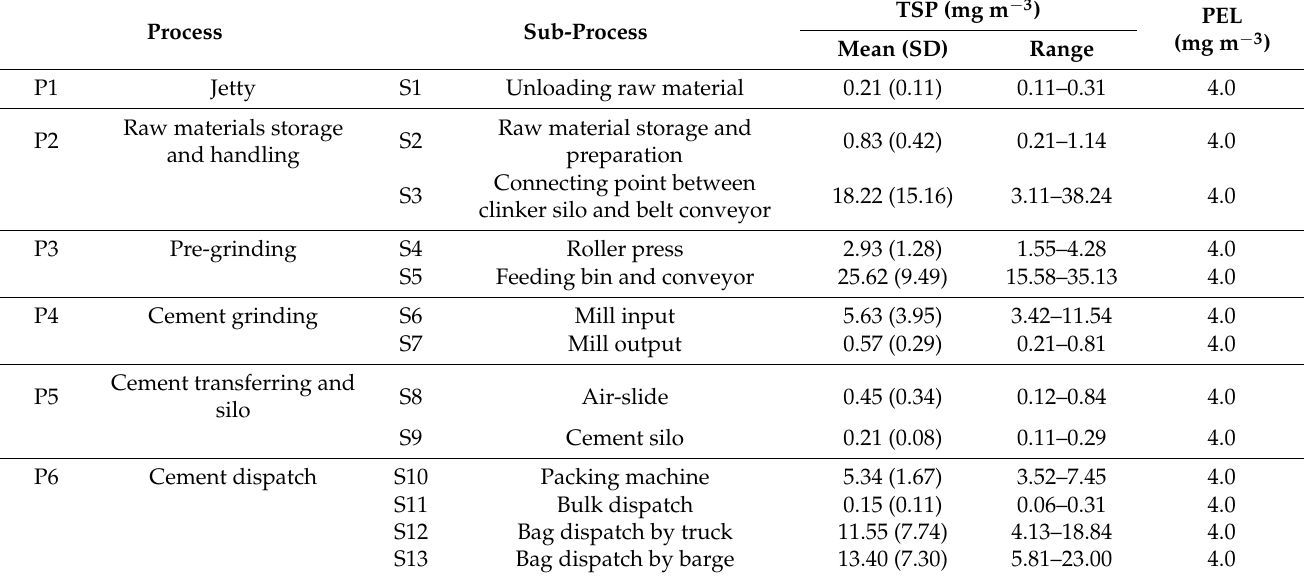
Table 2. The TSP at the cement grinding